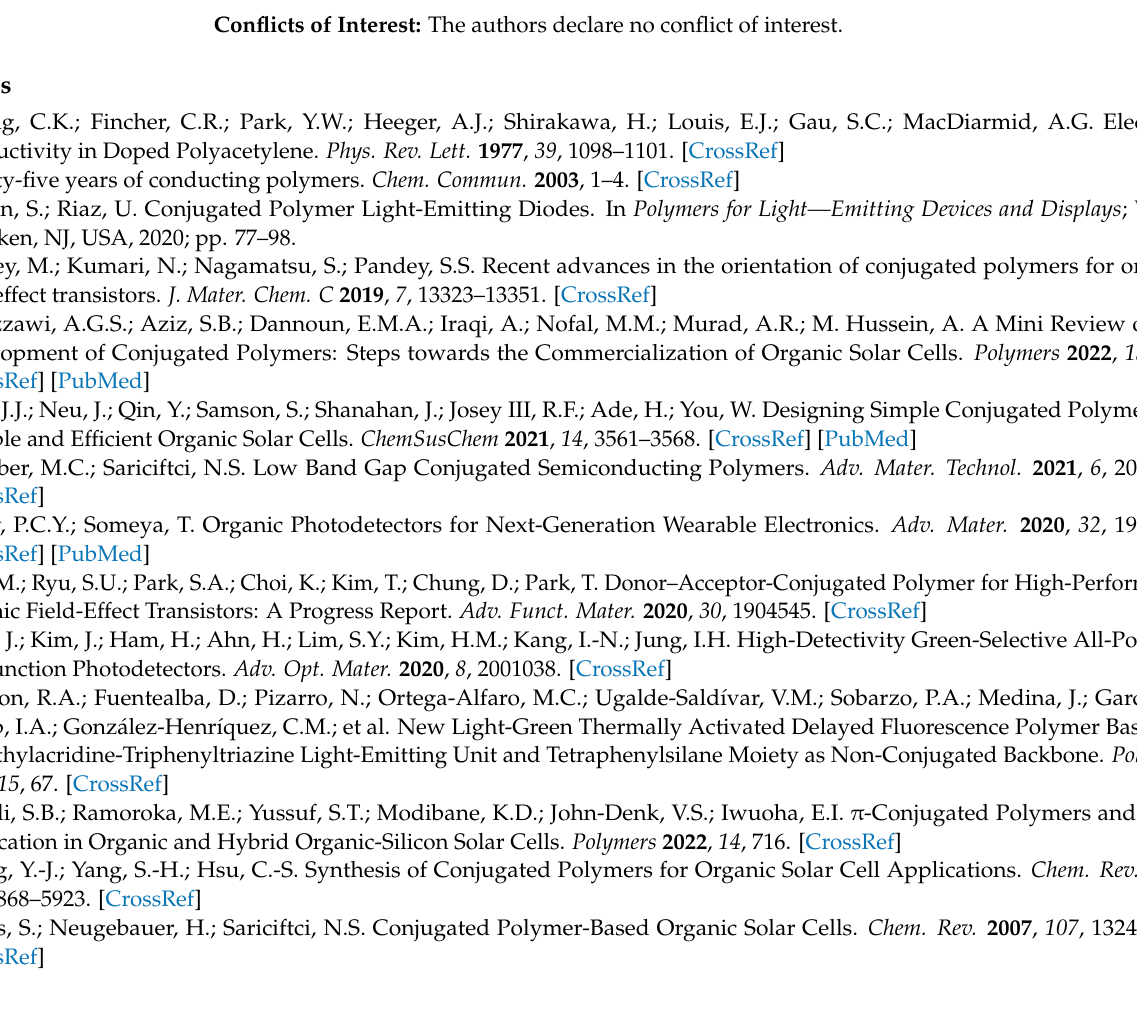
H NMR of compound 4; Figure S3: 1 H NMR of compound 5; Figure S4: 1 H NMR of compound 6; Figure S5: 1 H NMR of compound 7; Figure S6: 1 H NMR of PBC1; Figure S7: 1 H NMR of PBC2; Figure S8: 1 H NMR of PBC3; Figure S9: GPC spectrum of PBC1; Figure S10: GPC spectrum of PBC2; Figure S11: GPC spectrum of PBC3; Figure S12: Output characteristics of (a,d) PBC1, (b,e) PBC2 and (c,f) PBC3 devices in as-casted films (a,b,c) and after thermal annealing (d: 200 ◦ C, e: 100 ◦ C, f: 100 ◦ C); Figure S13: Atomic force microscopy (AFM) topography (2 µ m × 2 µ m) of the PBC2 thin films at the as-cast, 100 ◦ C, and 150 ◦ C annealing conditions; Figure S14: Two-dimensional grazing incidence X-ray diffraction (2D-GIXD) patterns of PBC1 depending on the thermal annealing temperature; Figure S15: 2D-GIXD patterns of PBC2 depending on the thermal annealing temperature; Figure S16: 2D-GIXD patterns of PBC3 depending on the thermal annealing